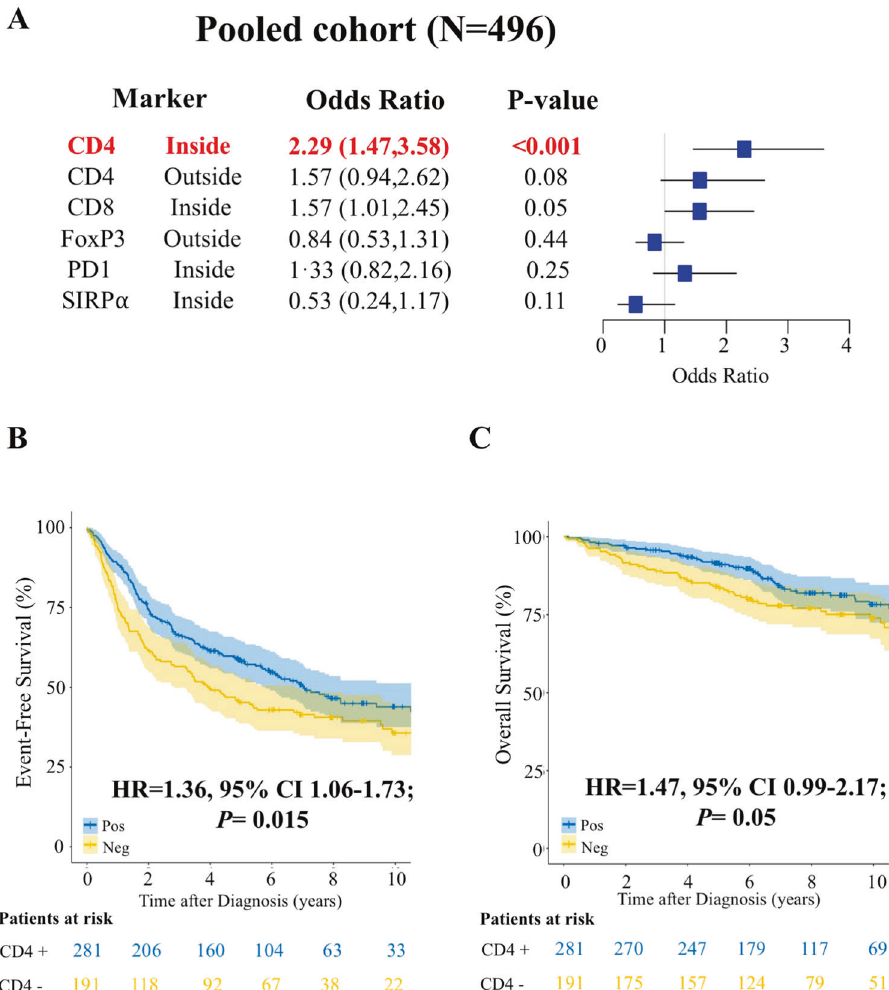
Fig. 1 Absence of intrafollicular CD4 + expression is an independent prognostic factor in follicular lymphoma. A Forest plots showing the association between indicated immune biomarkers and early failure in the pooled cohort ( N = 496) of follicular lymphoma patients. B and C Kaplan – Meier curves representing event-free survival ( B ) and overall survival ( C ) in the pooled cohort of follicular lymphoma patients with a positive (blue) or negative (yellow) intrafollicular CD4 + CD4 + expression. This new classi fi cation moved about 40% in each FLIPI risk group to the next higher BioFLIPI group, with 10% of the overall cohort in the new highest-risk group (Supplementary Table 5 and Fig. 2A). BioFLIPI was a better predictor of early failure than FLIPI.